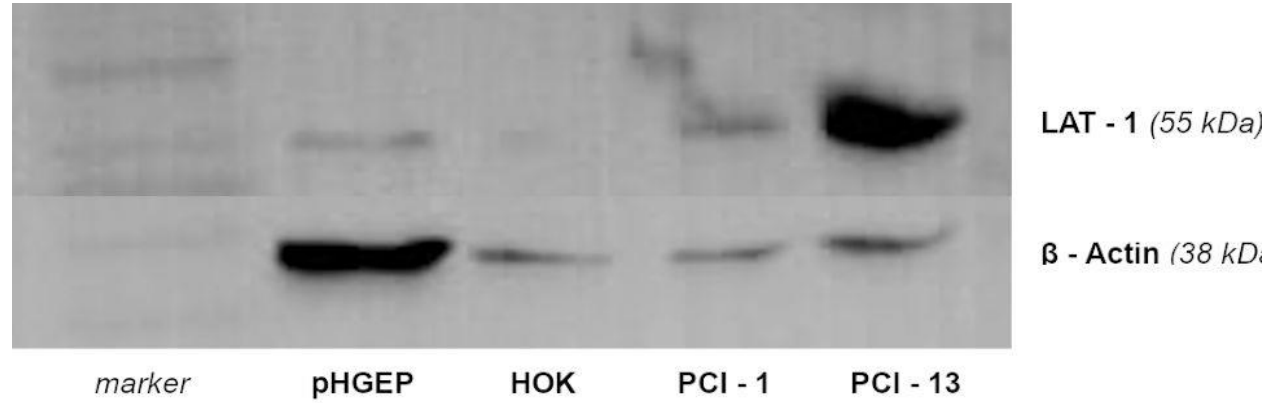
Figure 2. Results of Western blot for proteins from PCI 1 and PCI 13. LAT-1 is detectable for both cell lines at 38 kDa. Human oral keratinocytes (HOK) and pooled human gingival epithelial cells (pHGEP) were used as control. The expression is clearly higher in PCI 1 and PCI 13 when compared to controls.